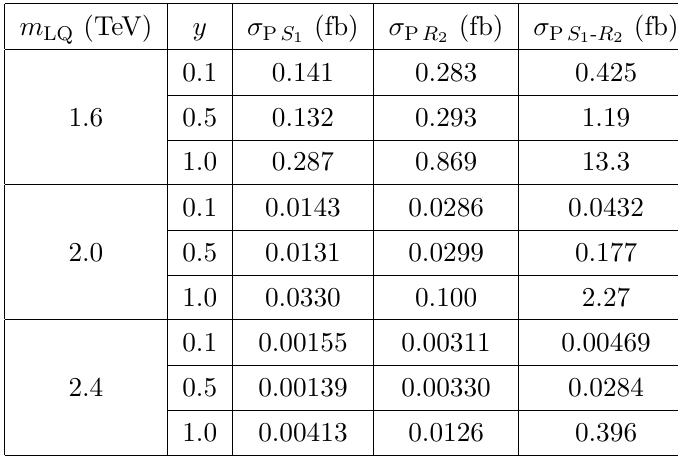
Table 1 . The leading order cross sections for the leptoquark pair production within the S 1 , R 2 , and S 1 - R 2 scenarios through the proton-proton collisions at 13 TeV center-of-mass energy, where in all three instances leptoquarks of mass m LQ couple exclusively to a right-chiral muon and the first generation quarks, as allowed by the Standard Model gauge group, with the coupling strength y